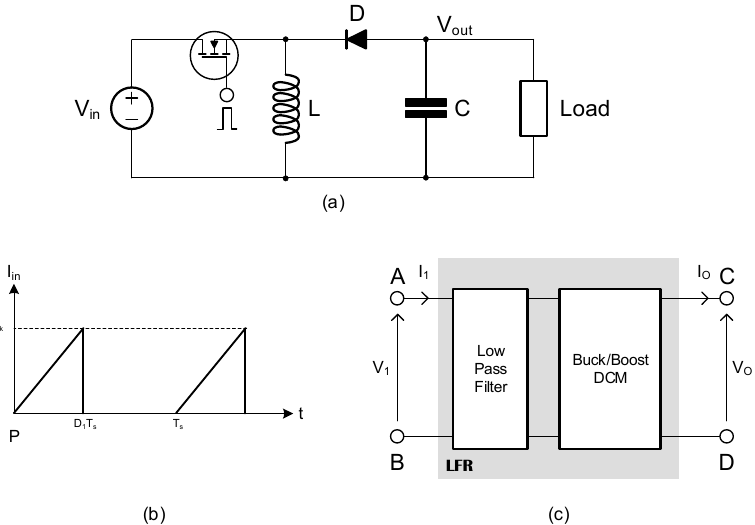
Figure 6. ( a ) Buck-boost converter topology; ( b ) input current waveform indicating DCM operation; ( c ) LFR realization of the converter.